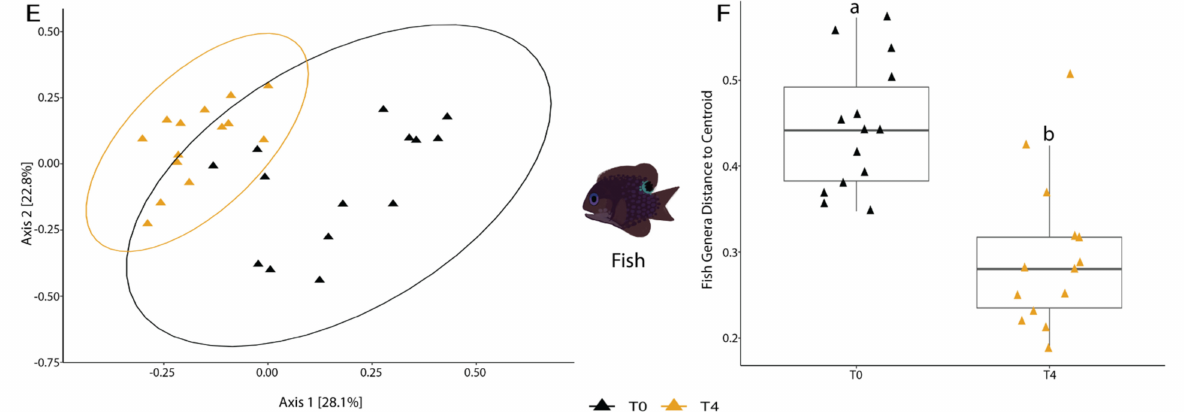
Figure 3. Significant beta diversity results for coral, fish, and algal matrix microbiomes. Bray-Curtis dissimilarity was significantly different between control and nutrient treated coral microbiomes ( A ), and was significantly different across time for algal matrix microbiomes (( C ), T0–T4) and fish microbiomes (( E ), T0 and T4). Dispersion/variability, or distance to centroid, was significantly increased for coral microbiomes under nutrient enrichment compared to coral microbiomes under control conditions ( B ). Dispersion significantly increased over time for algal matrix microbiomes ( D ) and decreased over time for fish microbiomes ( F ). Lower-case letters indicate statistical significance, i.e. boxes that do not have any letters in common are significantly different from one another ( B , D , F ).